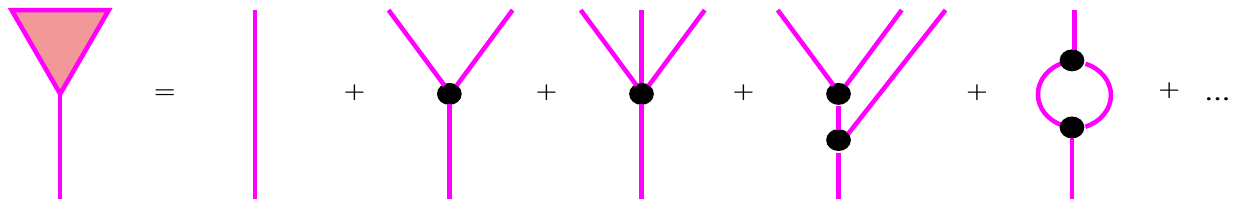
Fig. 2 ExamplesofenhancedPomerongraphsoflowestorders,contributingtothestructureoftheprojectileandtargettrianglesinFig.1;Pomerons are shown by thick lines and multi-Pomeron vertexes by filled circles